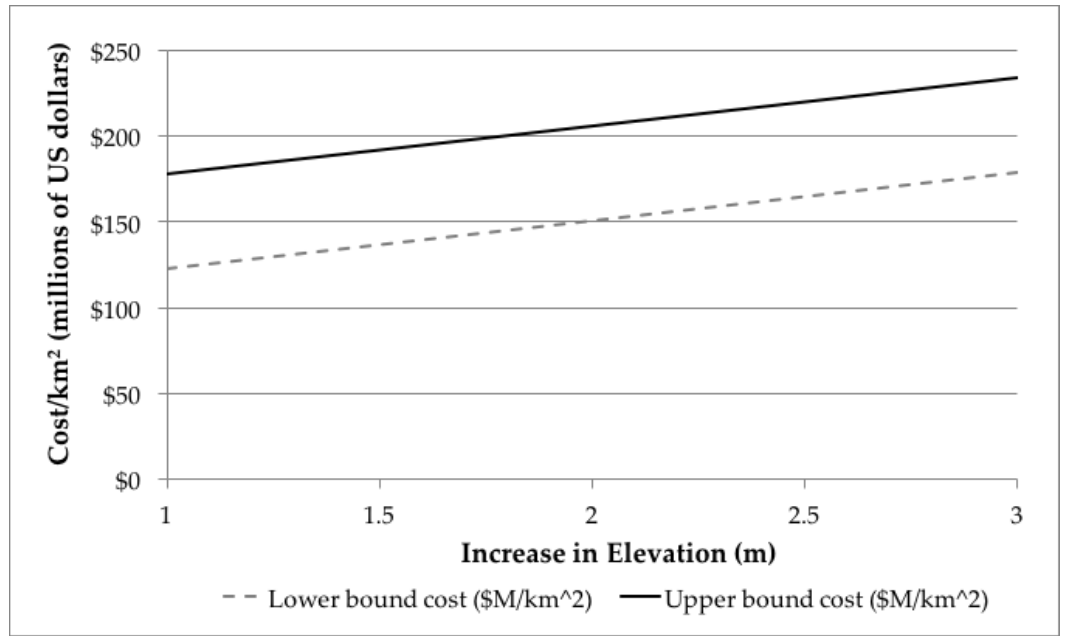
Figure 5. Upper and lower bound cost in US dollars per square kilometer of port area to increase port elevation and rebuild associated infrastructure as a function of increase in port elevation in meters.